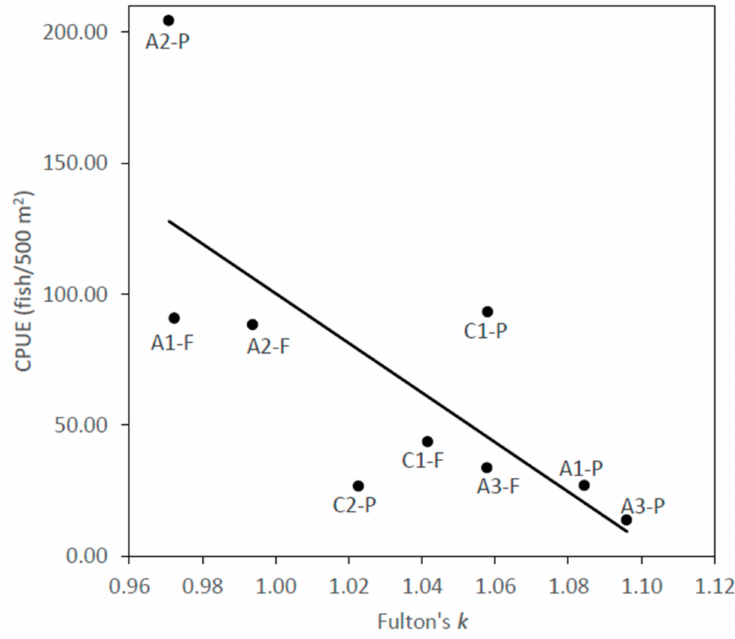
Figure 2. Scatter plot of catch per unit effort (CPUE) (fish/500 m 2 ) and mean O. mykiss fish condition ( k ) across nine headwater sites from Central Chile (R 2 =